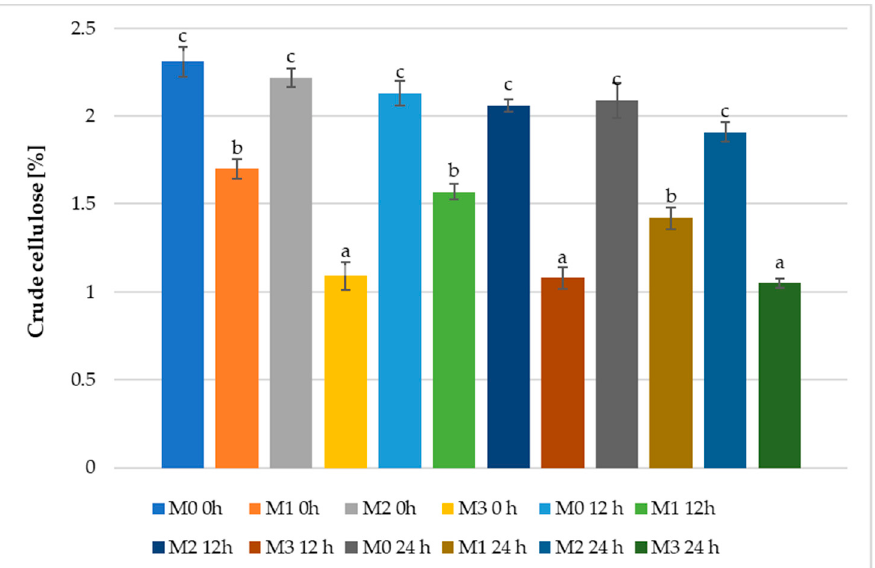
Figure 3. Crude cellulose in sourdough with wheat flour (M 0 ), einkorn flour (M 1 ), spelt flour (M 2 ), and emmer flour (M 3 ), fermented for 0, 12, and 24 h with Lactiplantibacillus plantarum ATCC 8014. Results are represented as mean values ± standard deviation (SD); n = 3. Different small letters show the significant difference ( p < 0.05) between samples at the same moment (0, 12, 24 H).